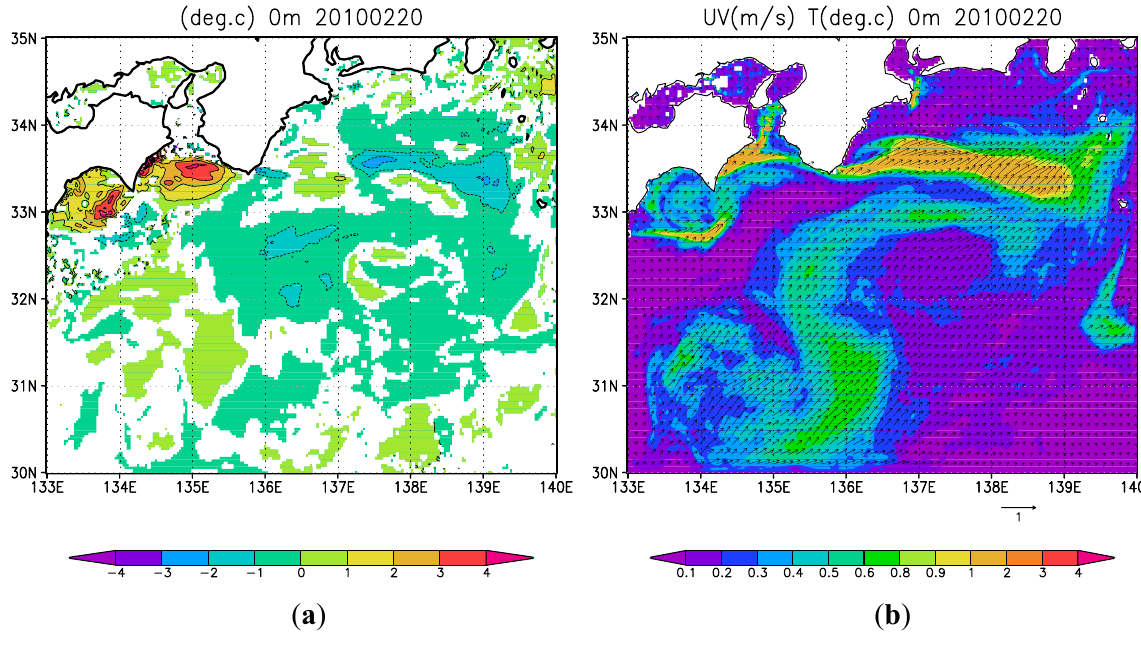
Figure 7. ( a ) As in Figure 6b except for the case ‘dqc.m2’. ( b ) The ensemble spread of the case ‘dqc.m2’ for the EnKF analysis on February 20 2010. Shades (vectors) denote the spread of SST (surface current).